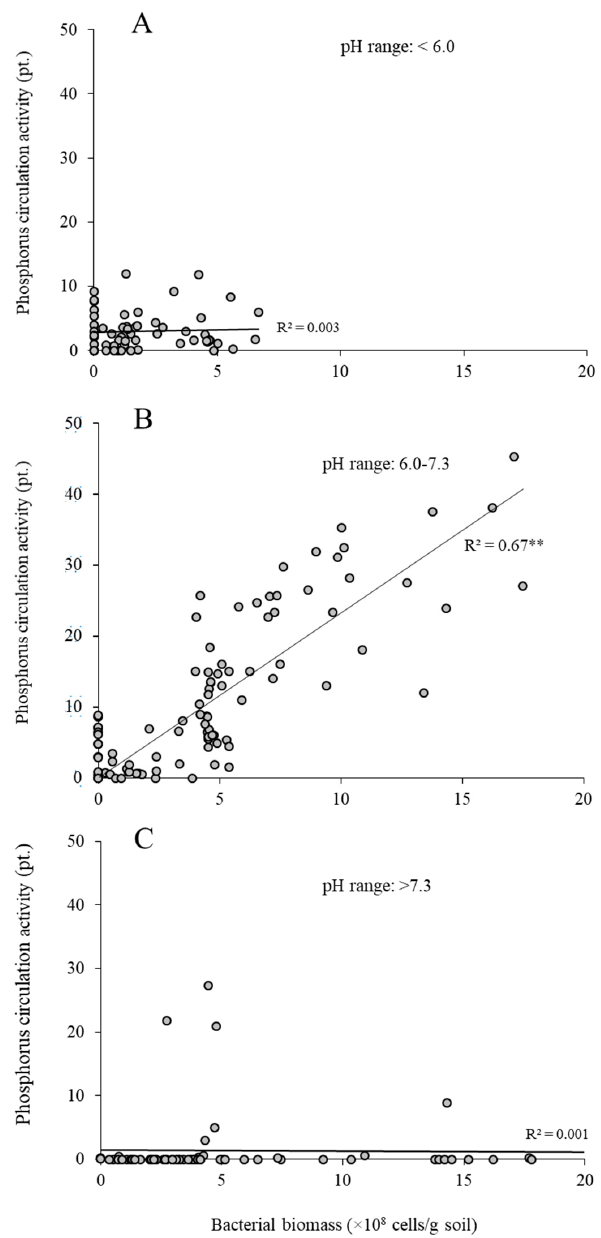
Figure 3. Relationship between phosphorus circulation activity and bacterial biomass in agricultural soil at different pH ranges. ( A ) Acid (pH < 6.0, n = 60); ( B ) near-neutral (pH 6.0 – 7.3, n = 94); ( C ) alkaline (pH > 7.3, n = 78). R 2 -value marked with two asterisks (**) indicates a significant regression ( p < 0.01).